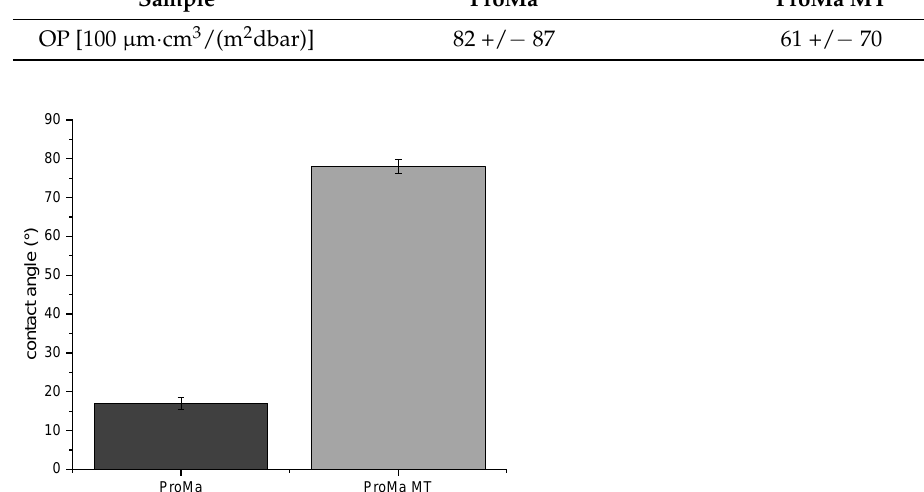
Table 1. The oxygen permeability (OP) of the ProMa barrier coating and the multilayer coating ProMa MT, n = 6.